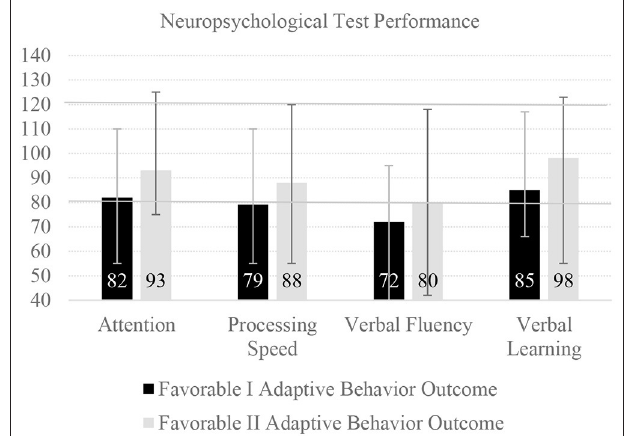
FIGURE 3 | One-year neuropsychological outcome following cardiac arrest in children and adolescents. There were 41 youth in this study with outcome data at one-year post cardiac arrest (median age = 14.3, interquartile range = 10.3–16.4), with parent-rated mean pre cardiac arrest adaptive behavior composite scores of 103.9 (SD = 19.2) (30). There were 10 youth in the Favorable I group who had adaptive behavior composite scores between 70 and 84, and 25 in the Favorable II group who had adaptive behavior composite scores of 85 or greater. The bars represent mean scores and the error lines represent the range of scores. The neuropsychological tests were converted to have a normative mean of 100 and a standard deviation of 15, so 90% of youth in the normative sample would be expected to obtain scores between 80 and 120, demarcated with a solid horizontal line. The tests included were as follows: Attention (Digit Span), Processing Speed (Coding), Verbal Fluency (Controlled Oral Word Association Test), and Verbal Learning (California Verbal Learning Test-Children’s Edition Trials 1–5 Total Score). This figure uses means and ranges presented in Slomine et al. ( 30).